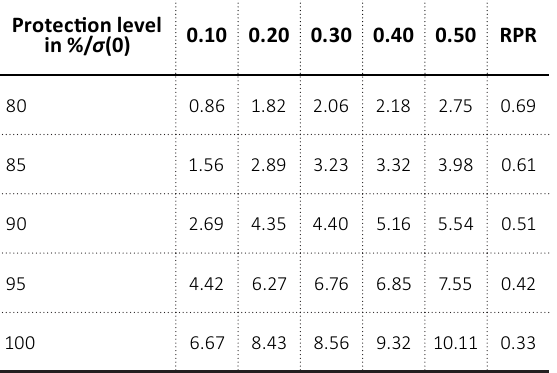
Table 3. American put option prices linked to the VolTarget strategy Protection level in %/ σ